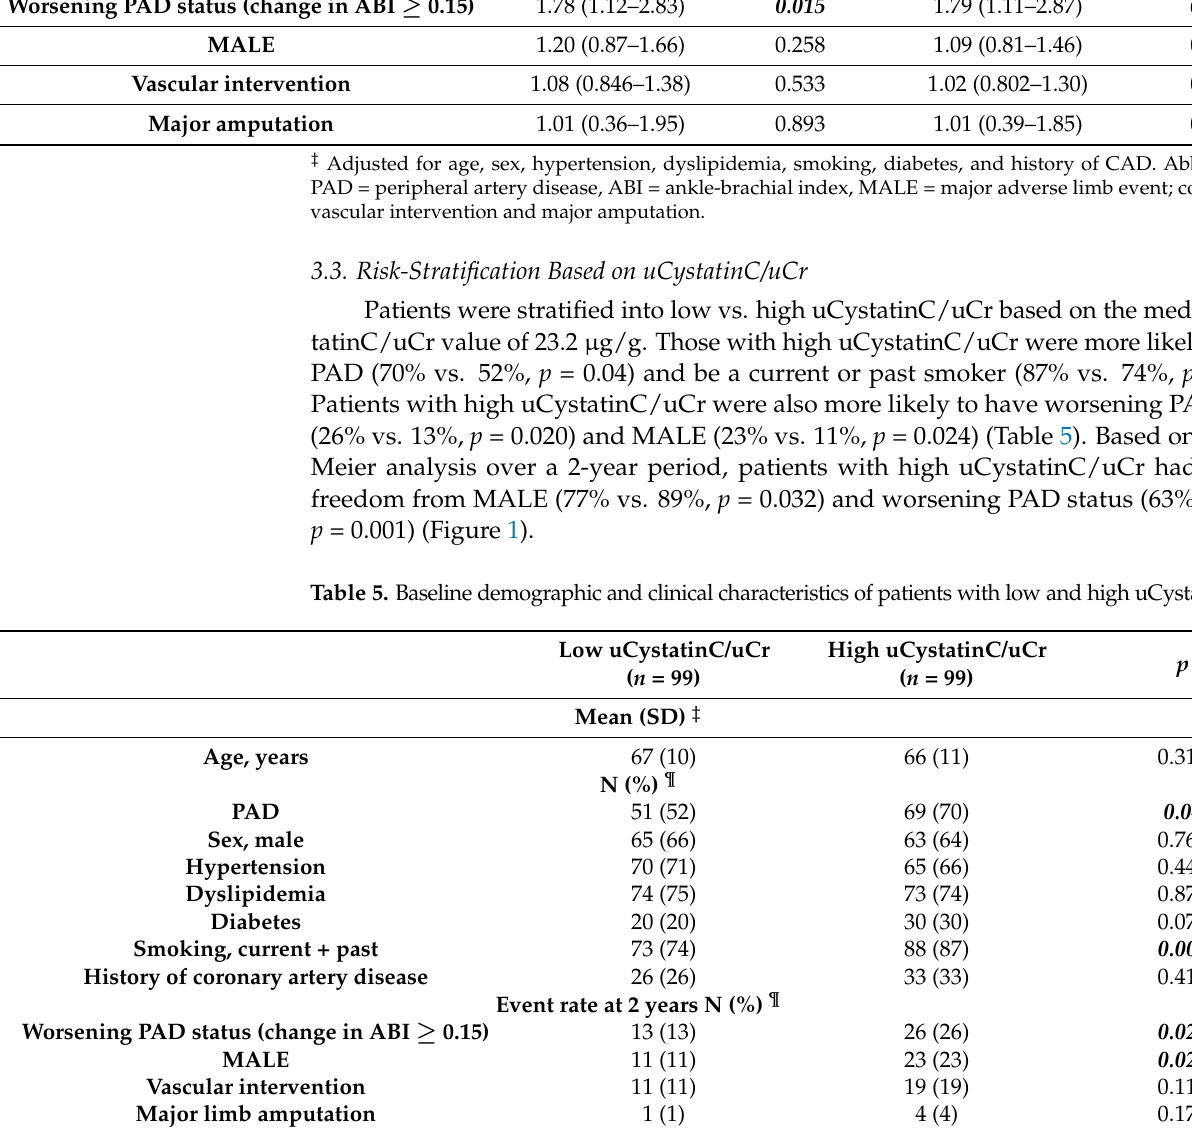
Table 4. Multivariable Cox regression models for associations between every one unit increase in log (uCystatinC/uCr) and PAD-related adverse events. Unadjusted HR (95% CI)